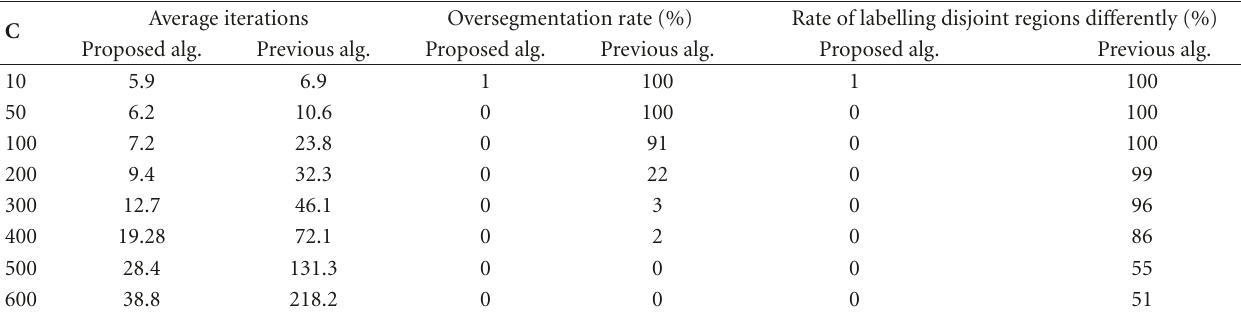
Table 1: Performance in terms of computational cost measured by average iterations, oversegmentation rate, and rate of di ff erently labelling disjoint regions of the same texture (%) with various values of C when the image in Figure 3 is divided into 64 blocks.